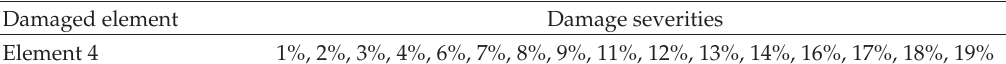
Table 4: Test samples used for